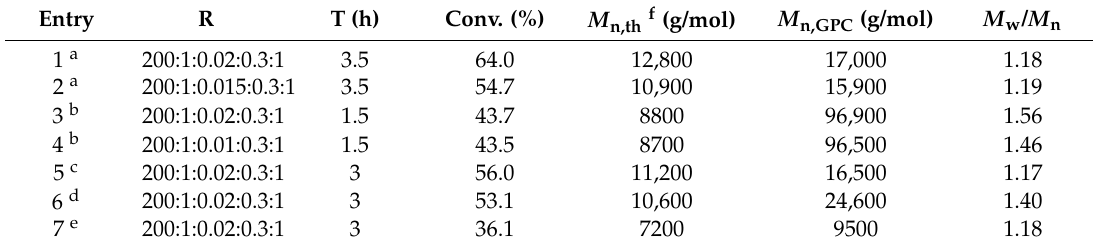
Table 1. Effect of different initiators and solvents on initiators for continuous activator regeneration (ICAR) Atom Transfer Radical Polymerization (ATRP) of methyl methacrylate (MMA).